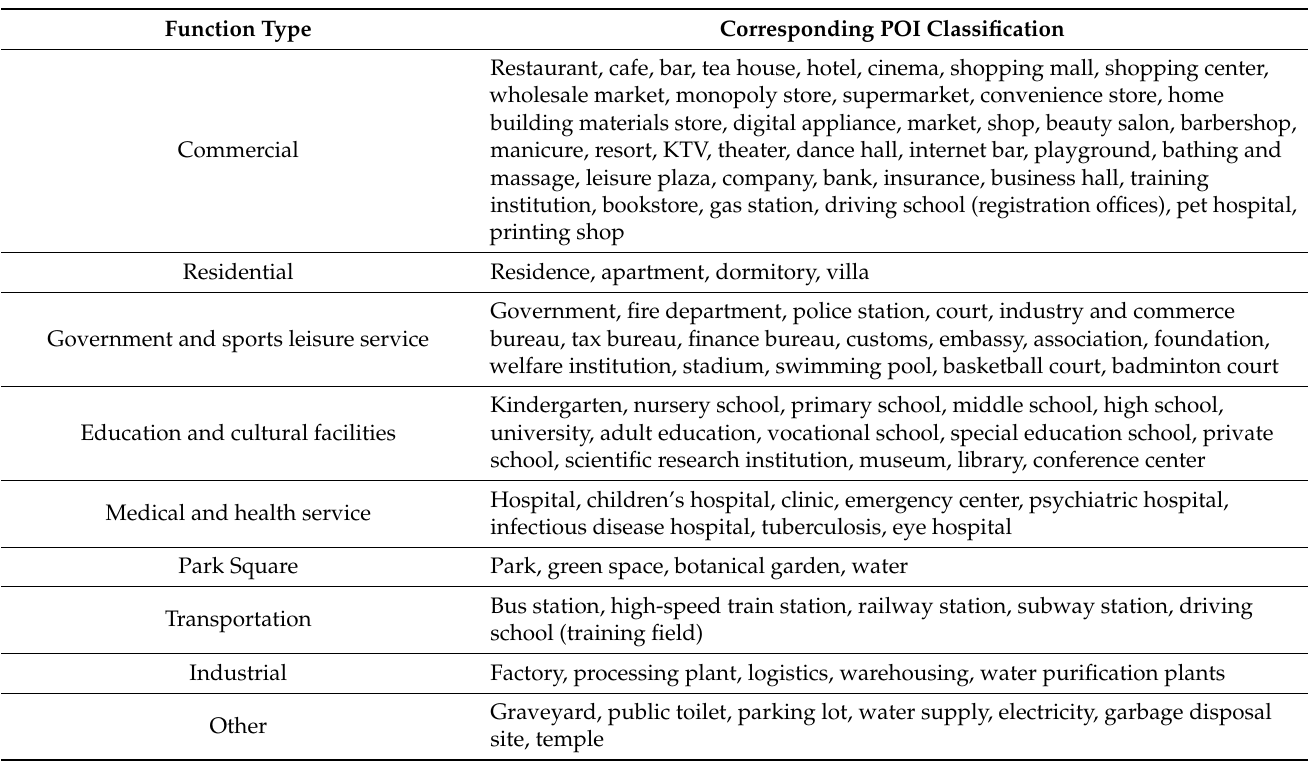
Table 2. POIs function classification table.